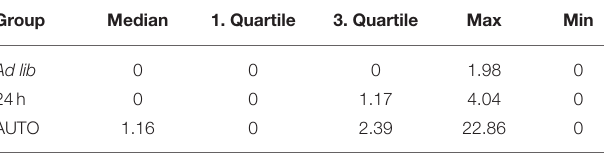
TABLE 4 | Relative frequencies of stereotypic behaviors (interval with stereotypies/active intervals).